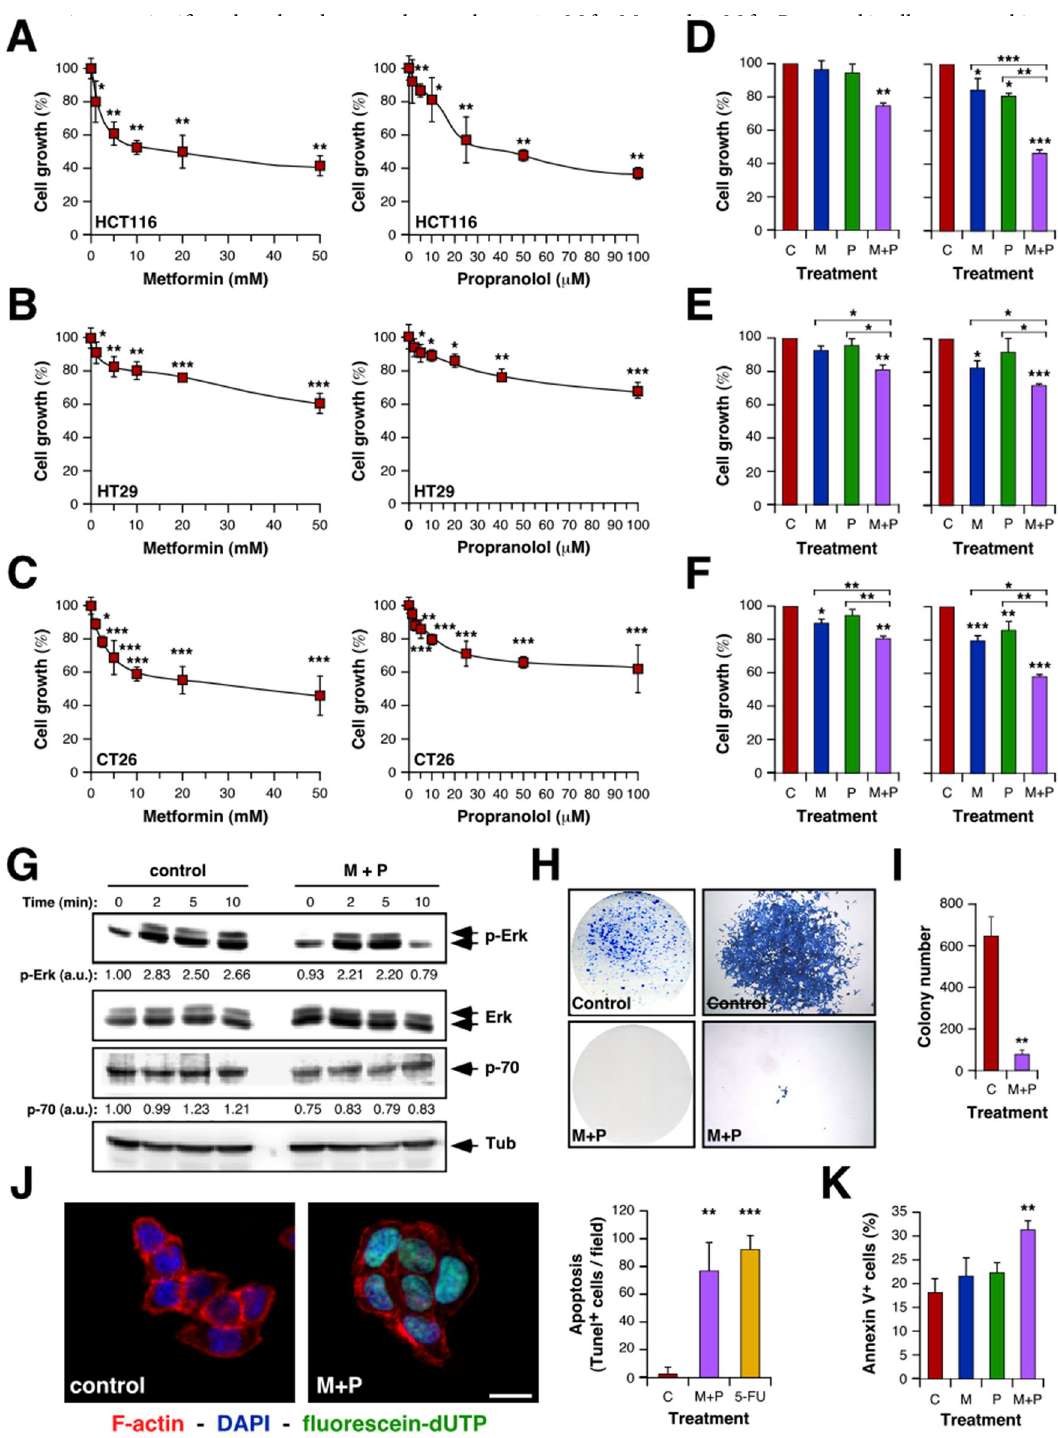
Figure 1. Characterization of the effect of Met and Prop on CRC cells viability. CRC cells were cultured in the presence of the indicated doses of Met or Prop ( A – C ) during 36 h. The number of living cells was estimated by tetrazolium salts reduction method (n = 3). ( D – F ) HCT116 ( D ), HT29 ( E ) and CT26 ( F ) cells were treated for 24 h with Met (M; 1 mM left, 2.5 mM right), Prop (P; 1 µM left, 2.5 µM right) or a combination of them (M + P) and living cells were estimated as before (n = 3). ( G ) Western blot analysis showing the phosphorylation and expression status of Erk and p70 in serum-stimulated HCT116 cells. Cells were treated for 30 min with M + P (M 2.5 mM; P 2.5 µM) before released in complete media. Tubulin was used as loading control (n = 3). Quantification of phosphorylation levels is indicated. ( H , I ) Cells (500 cells/well) were cultured in the presence of M + P during 8 days. Colonies were stained ( H ) in order to allow quantification ( I ). ( J ) TUNEL assay (left, scale bar = 100 µm) and quantification (right) of HCT116 apoptotic cells after M + P treatment. 5-FU was used as a control (n = 3). ( K ) Quantification of apoptotic (annexin V + ) HCT116 cells by flow cytometry after single or combined treatment (n =